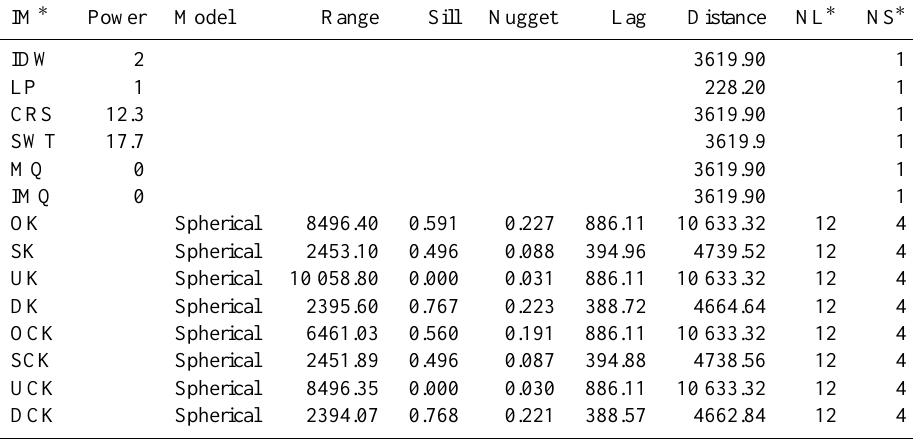
Table 1. Parameters of interpolation methods calculated only on point data gathered by bathymetric measurement.